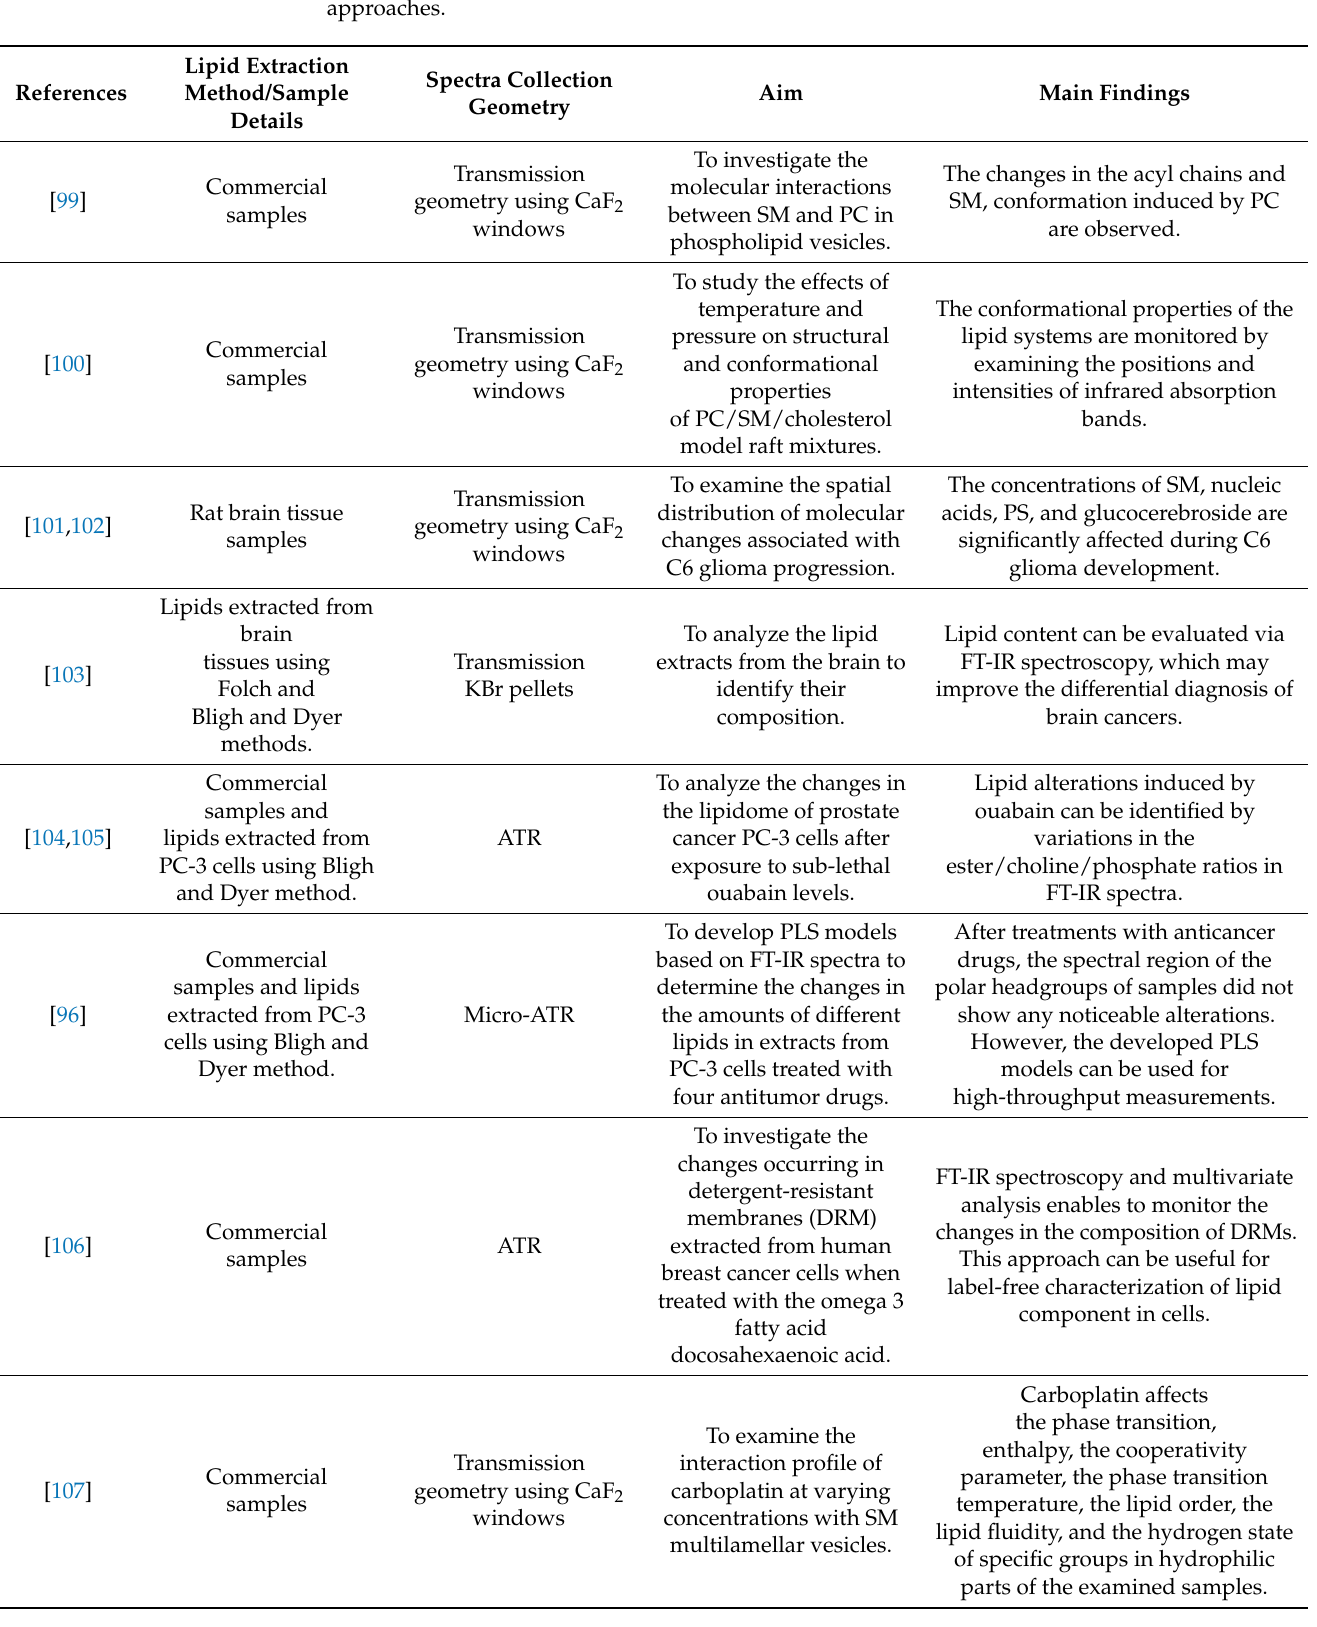
Table 4. Summary of some relevant results obtained on SM by using different FT-IR spectroscopy